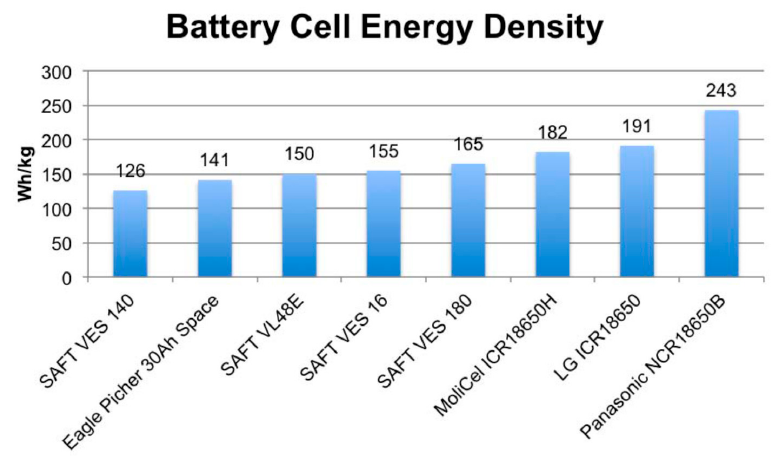
Figure 9. Li-Ion and Li-Po Energy Densities for Off the Shelf Products [30].